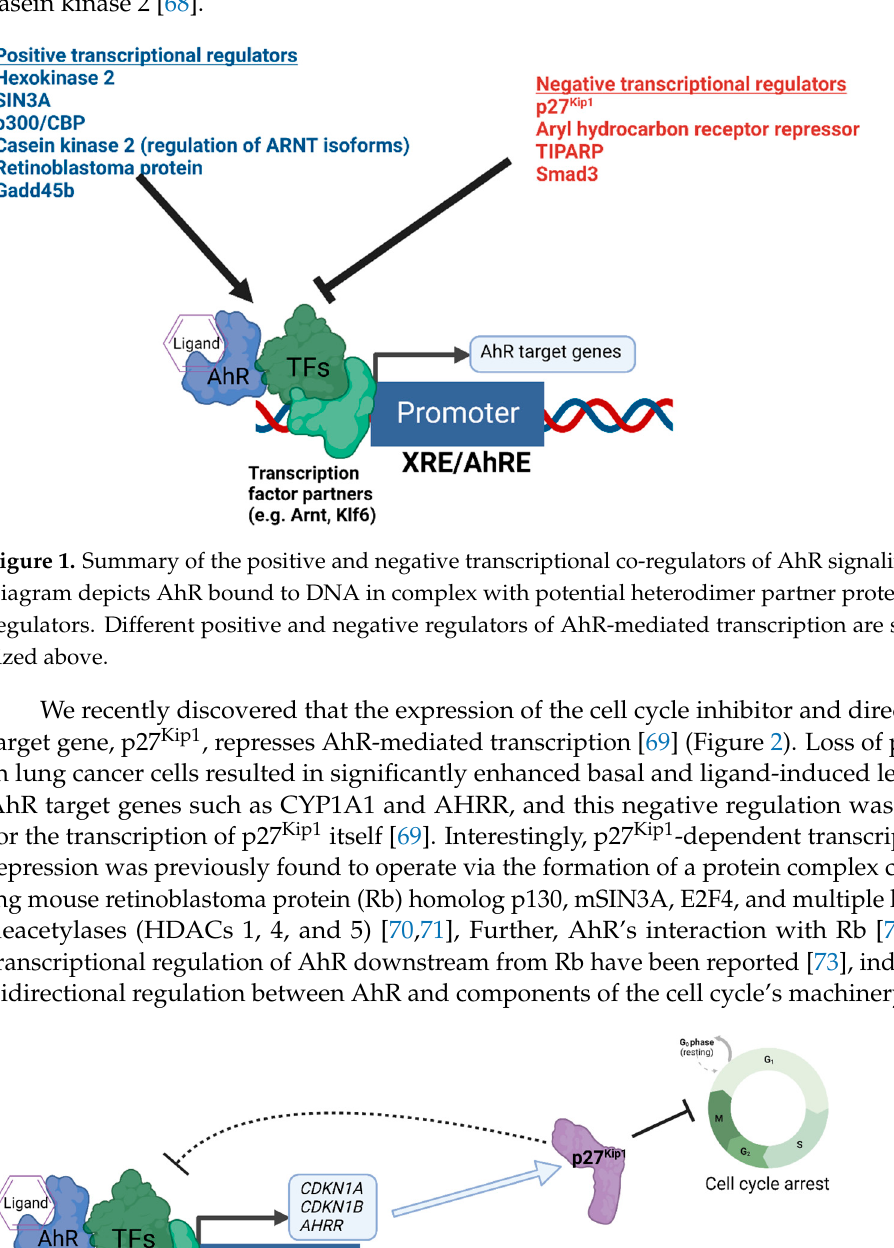
Figure 1. Summary of the positive and negative transcriptional co-regulators of AhR signaling. The diagram depicts AhR bound to DNA in complex with potential heterodimer partner proteins and regulators. Different positive and negative regulators of AhR-mediated transcription are summa- rized above.